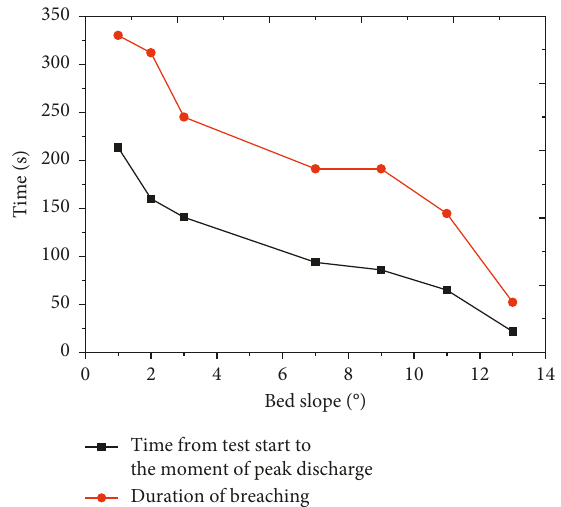
Figure 7: The relationship between time from test start to the moment of peak discharge and duration of hydrograph and bed